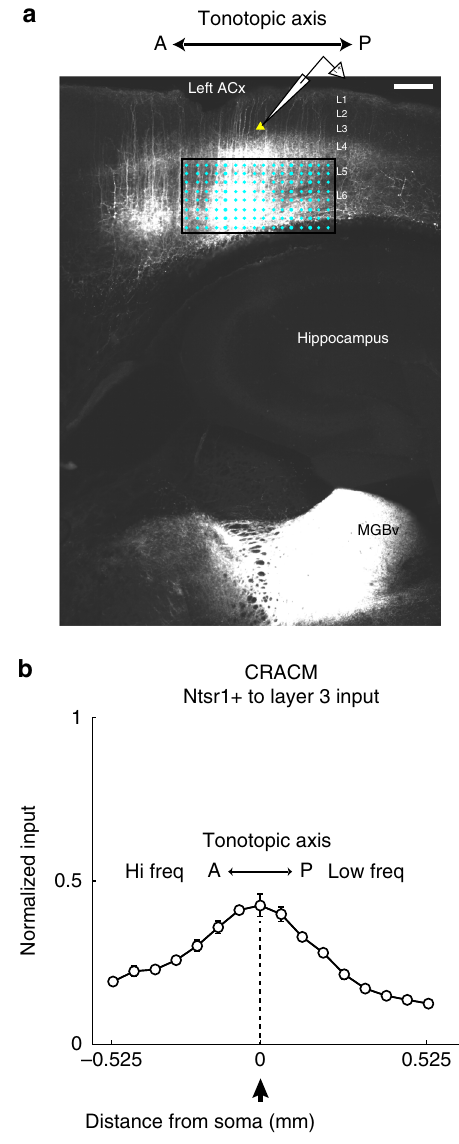
Fig. 6 Channelrhodopsin-assisted mapping of L6-Ntsr1 input to L3. a Confocal image of channelrhodopsin expression in the auditory cortex. Axons are clearly seen in the auditory thalamus (MGBv). Neurons in L3 centered on the injection bolus were targeted for whole-cell